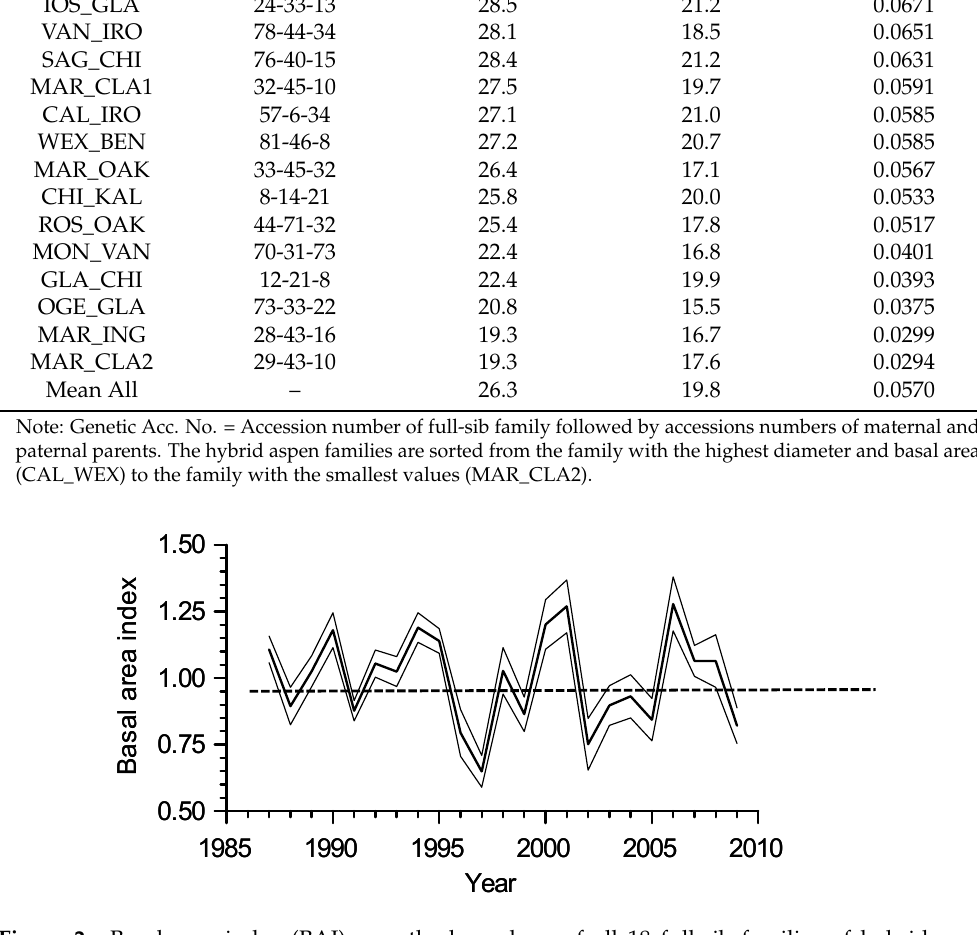
Table 2. Coefficients of regression models relating radial growth of hybrid aspen families to temperature variables. Climate variables (V) are identified in Figure 3.